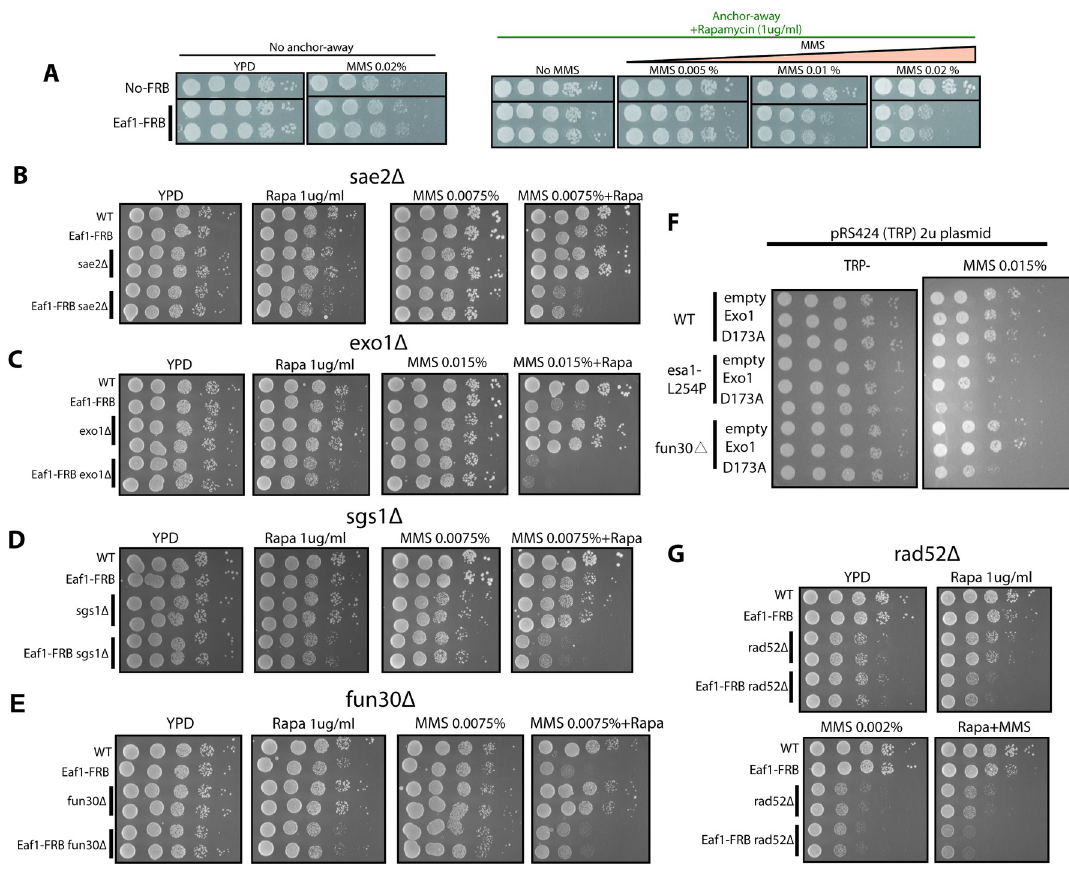
Fig 2. NuA4 shows genetic interaction with resection and recombination factors. A-E, G) 10-fold serial dilutions of indicated strains were spotted on solid medium without or with 1 μ g/ml rapamycin supplemented without or with indicated amounts of MMS and grown at 30˚C. Another subunit of NuA4 was used with the FRB tag, scaffold subunit Eaf1[12], as its depletion does not affect cell viability on rich media (A). Genetic interaction (sickness/growth defect in presence of DNA damage induced by MMS) is seen with genes for resection factors Sae2 (B), Exo1 (C), Sgs1 (D) but not Fun30 (E), and with recombination factor Rad52 (G). F) DNA damage sensitivity of esa1 ts cells cannot be overcome by over-expression of potent resection factor Exo1. Spot assays as above with the indicated strains. The fun30 deleted strain is used as control as it was shown to be rescued by Exo1 expression but not its catalytic mutant form (D173A) [28].